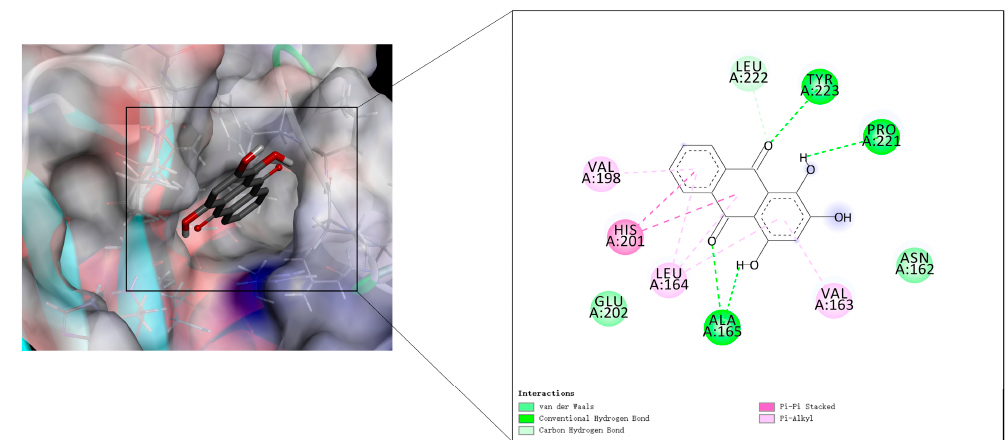
Figure 8. The interaction of purpurin and MMP3.